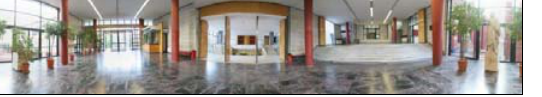
Figure 11. The initial panorama; the area within the black frame illustrates the useful area in vertical and 360o horizontally.